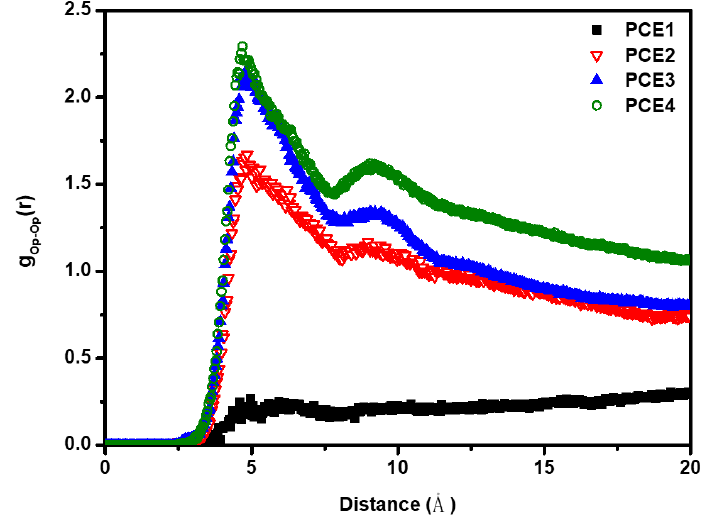
Figure 4. The radial distribution functions (RDFs) g Op-Op (r) in PCE aqueous systems.